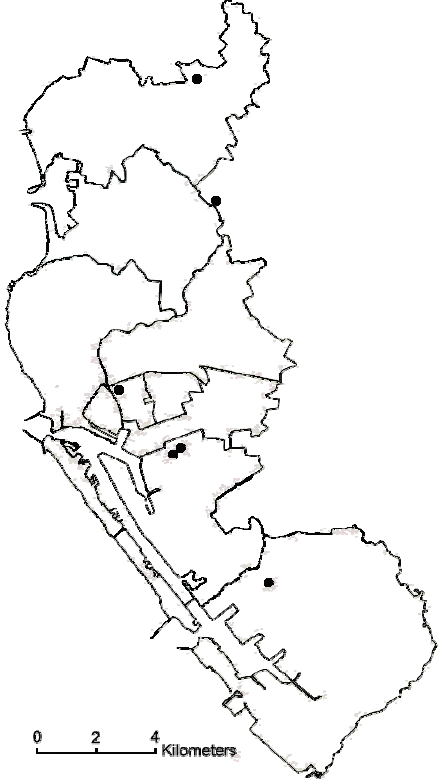
Figure 1. Map of Kaohsiung city showing location of the air quality monitoring